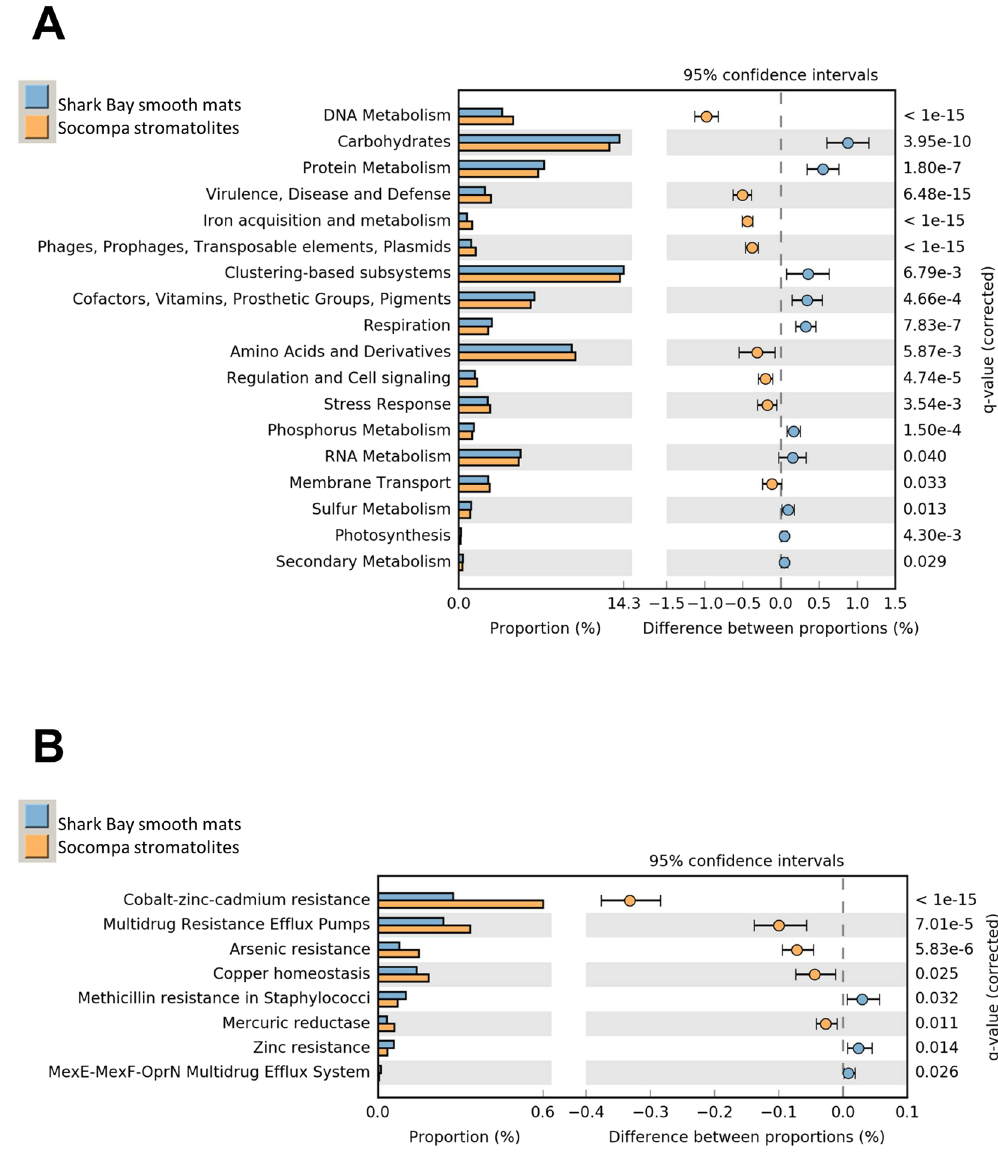
Figure 3. Comparison of Shark Bay smooth mats (blue) and Socompa stromatolites (yellow) by SEED subsystems at level 1 ( A ) and Virulence, defense and disease level 3 ( B ) using STAMP. Features displayed show significant